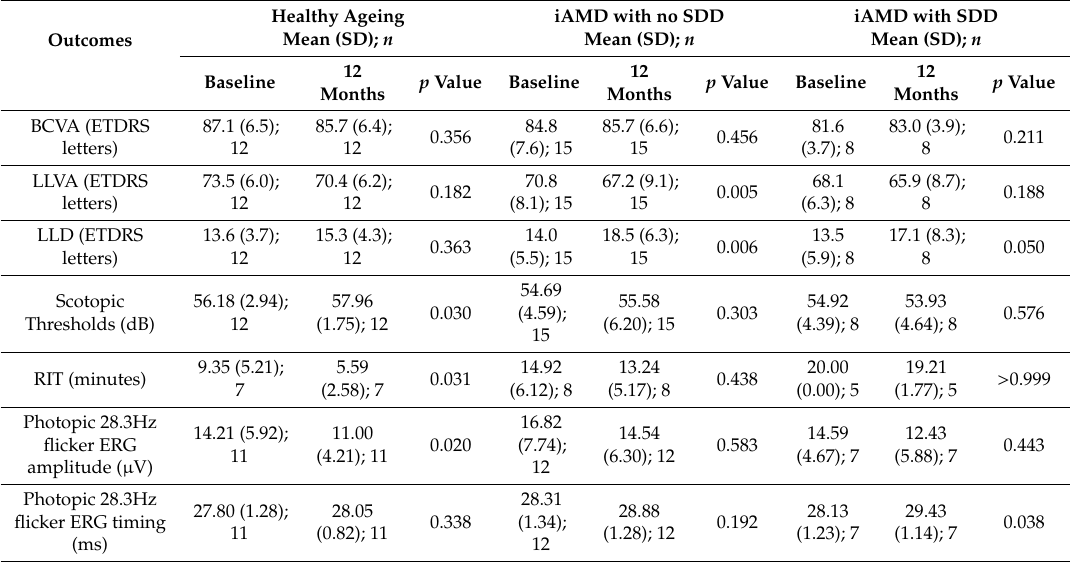
Table 2. Twelve-month change from baseline in functional outcome measures for each study group.